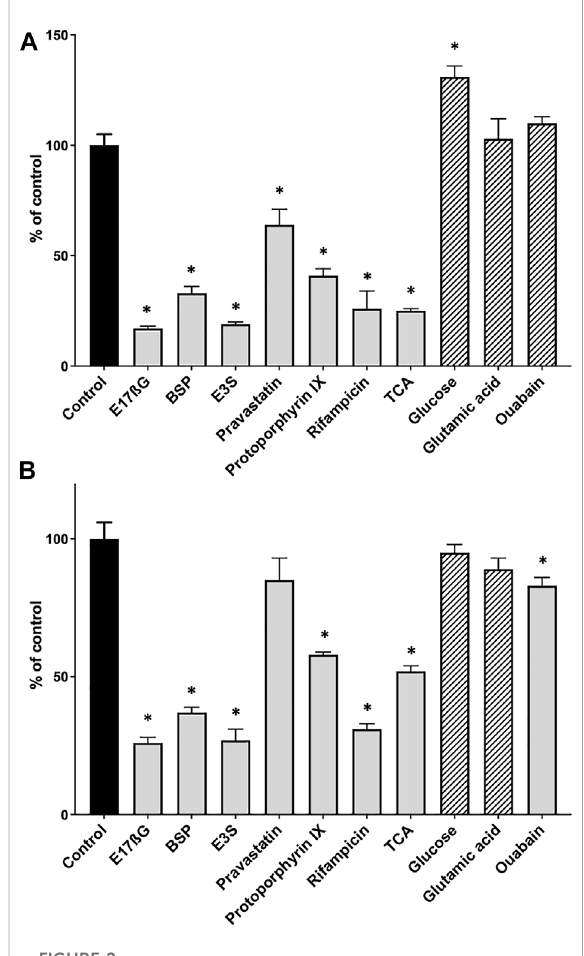
FIGURE 2 Positive and negative control substrates for the competitive counter fl ow assay in OATP1B1- and OATP1B3-expressing CHO cells. After cells expressing OATP1B1 (A) or OATP1B3 (B) were preloaded with 10 nM [ 3 H]-estradiol-17 β -glucuronide for 2 h at room temperature, concentrated solutions of known OATP substrates (positive controls, grey bars) and compounds that should not interact with OATPs (negative controls, hatched bars) wereaddedtoyield fi nalconcentrationsof100 µM.Aftera30-min incubation at room temperature, cell-associated radioactivity was measured and is presented as % of control (which did not get any compound treatment). Values are mean ± SD of quadruplicate determinations in a single experiment. * p < 0.05 as compared to the